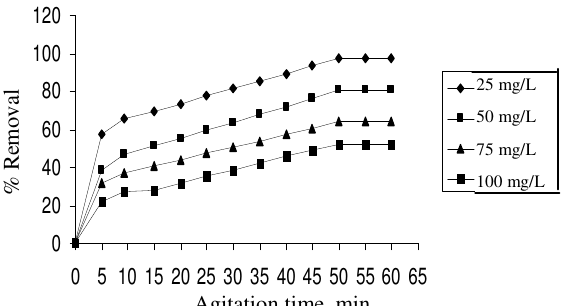
Figure 2. Effect of agitation time on crystal violet adsorption.